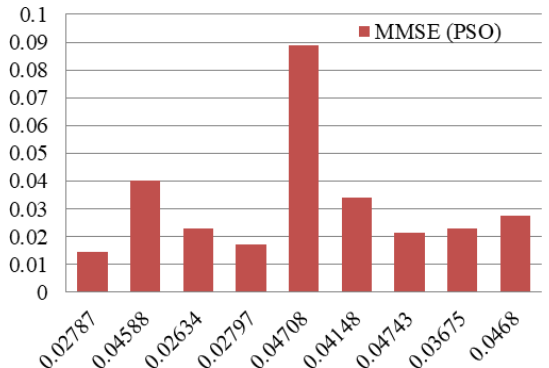
Figure 9: Values of MMSE calculated for various values of µ (PSO)